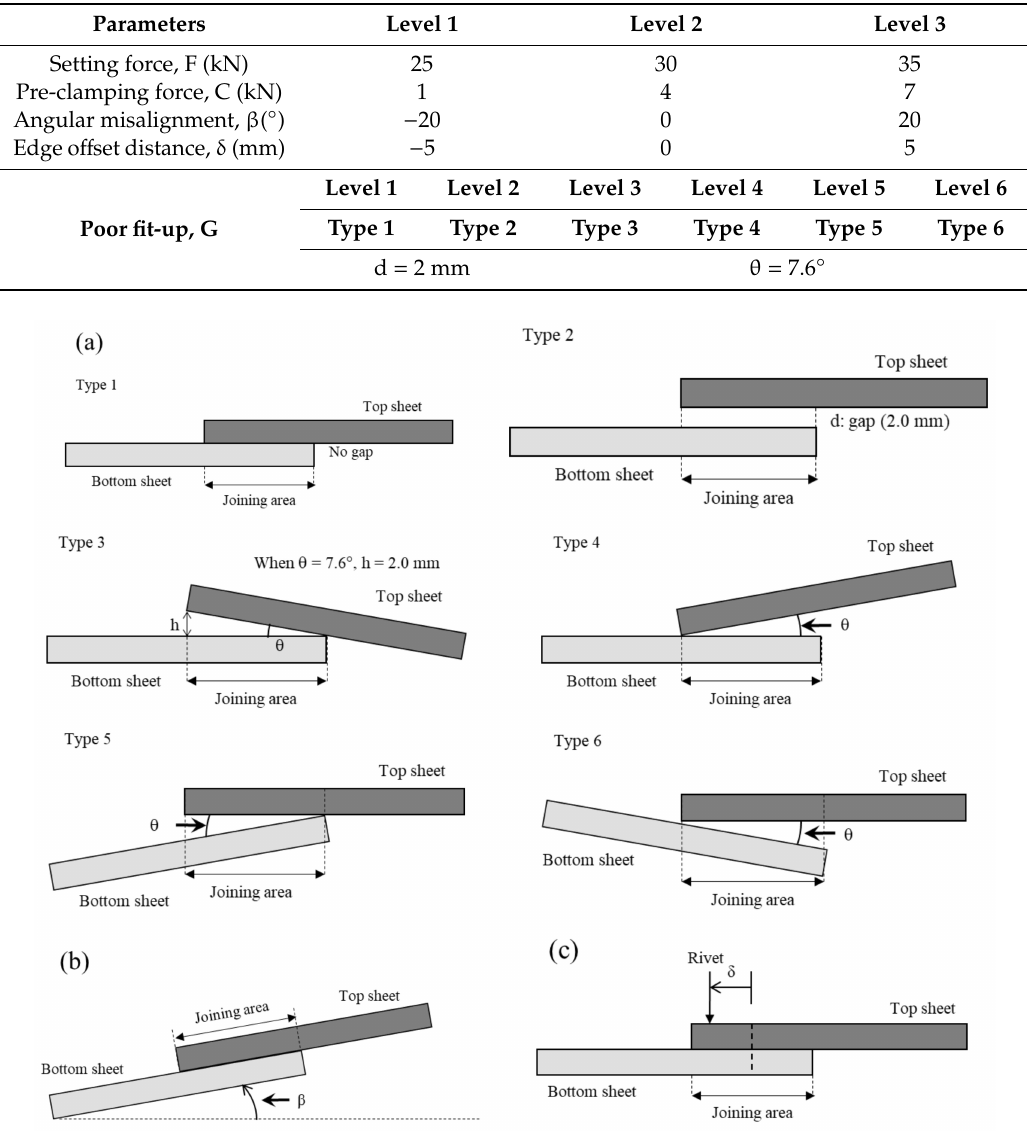
Figure 2. Abnormal joining conditions. ( a ) Poor fit-up; ( b ) angular misalignment; ( c ) edge o ff set (inaccurate setting force and pre-clamping force are not